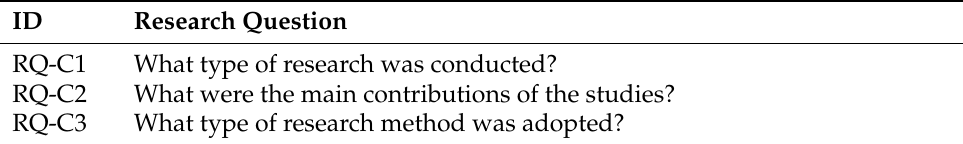
Table 4. Research questions on context.